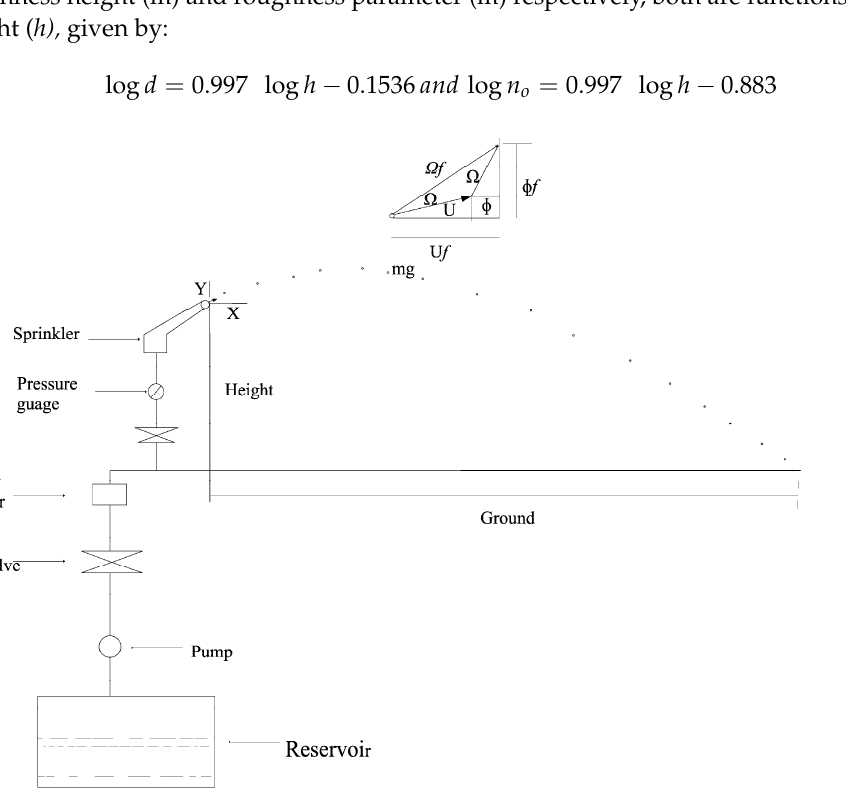
Figure 1. Schematic diagram of the droplet trajectory under no wind conditions. The fourth-order Runge-Kutta numerical integration techniques were used to solve Equations (1)–(3) for droplet